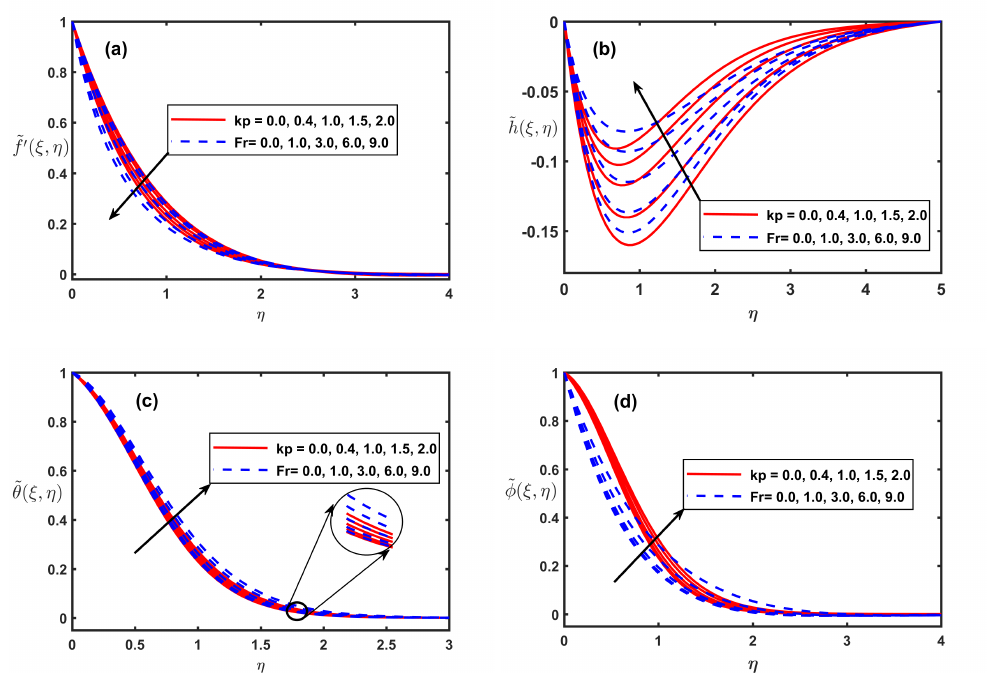
Figure 3. Fluctuation of ˜ f (cid:48) ( ξ , η ) , ˜ h ( ξ , η ) , ˜ θ ( ξ , η ) , and ˜ φ ( ξ , η ) along with kp and Fr.